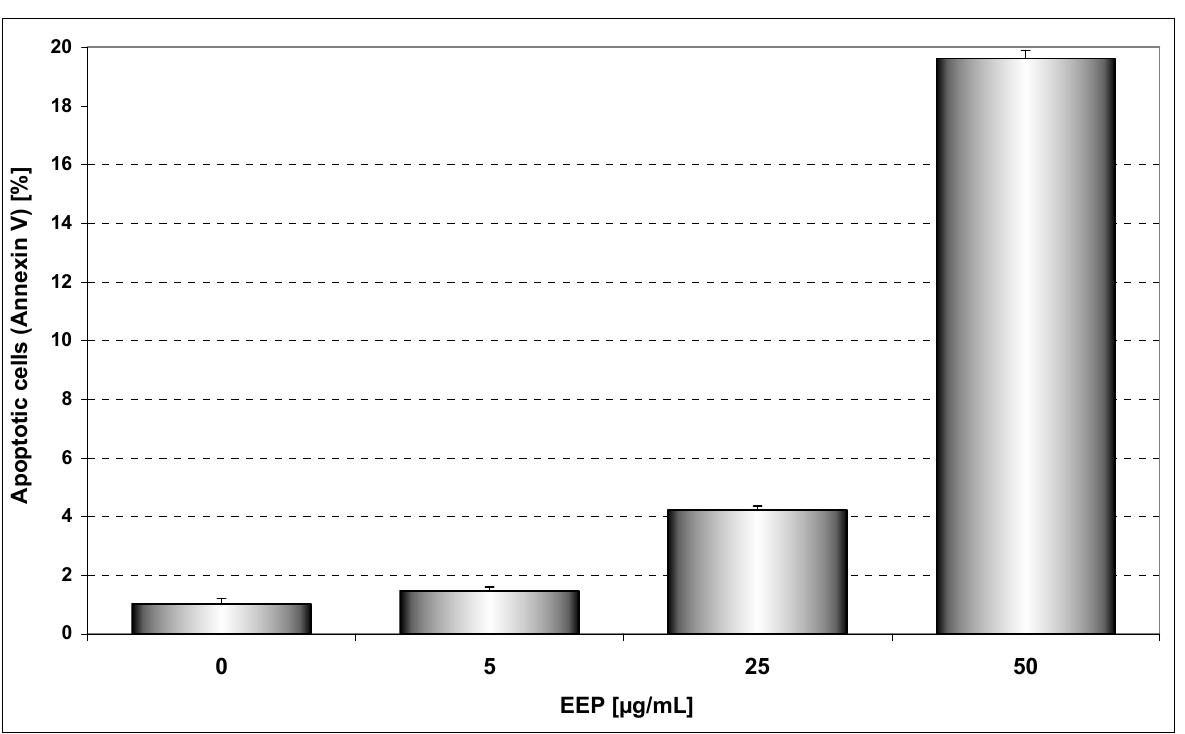
Figure 2. EEP induced apoptosis in HeLa cells. The cancer cells were incubated for 48 hours with EEP at the concentrations of 5 – 50 μ g/mL. Detection of apoptotic cell death by annexin V-FITC staining using flow